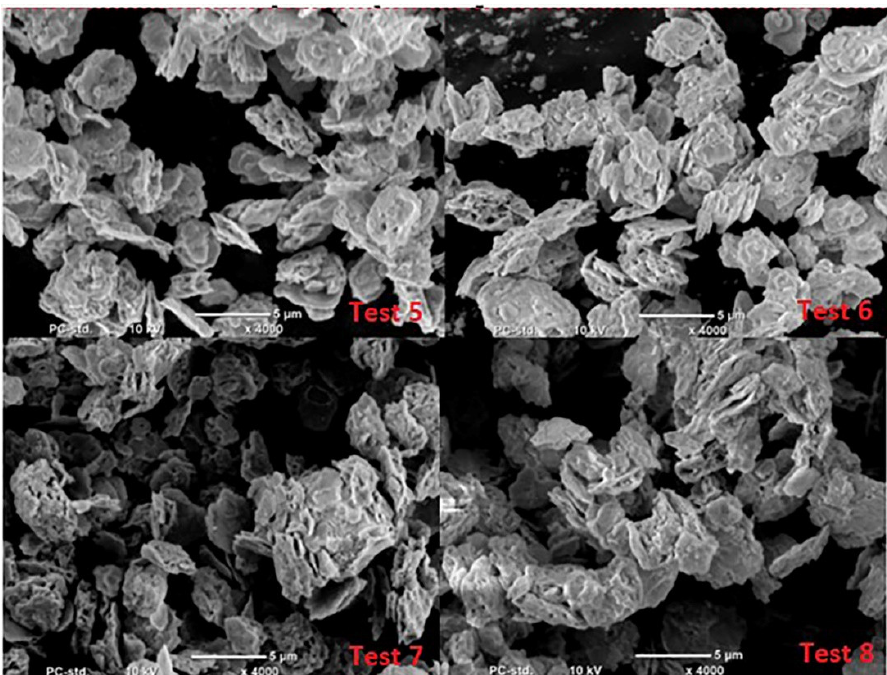
Figure 13. Structure of lead oxide obtained under conditions of low humidity of air fed to the reactor.